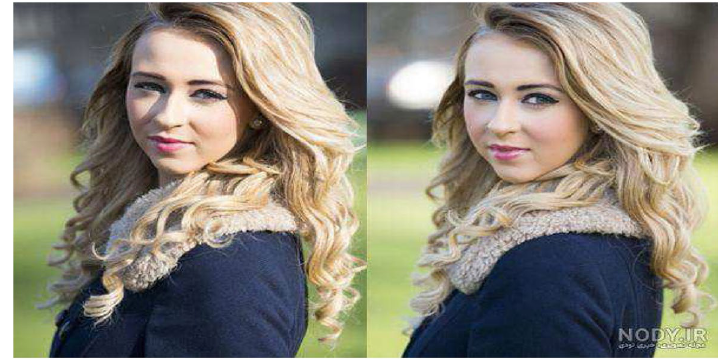
Fig. 9 TWIN-image where one version is taken under normal outdoor lighting and the other one under diffused